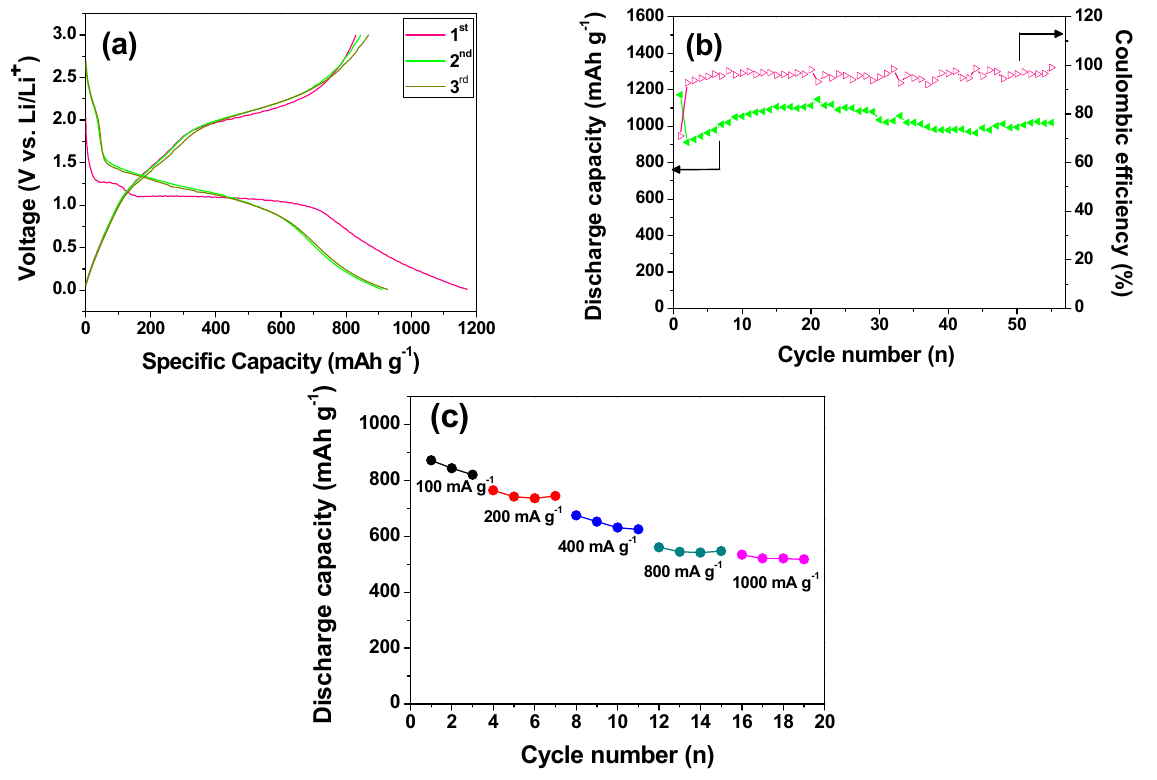
Figure 5. The lithium storage performance of the as-prepared Co 3 O 4 nanorods at a current density of 50 mA g − 1 . ( a ) The first three charge-discharge curves; ( b ) cycling performance; ( c ) rate